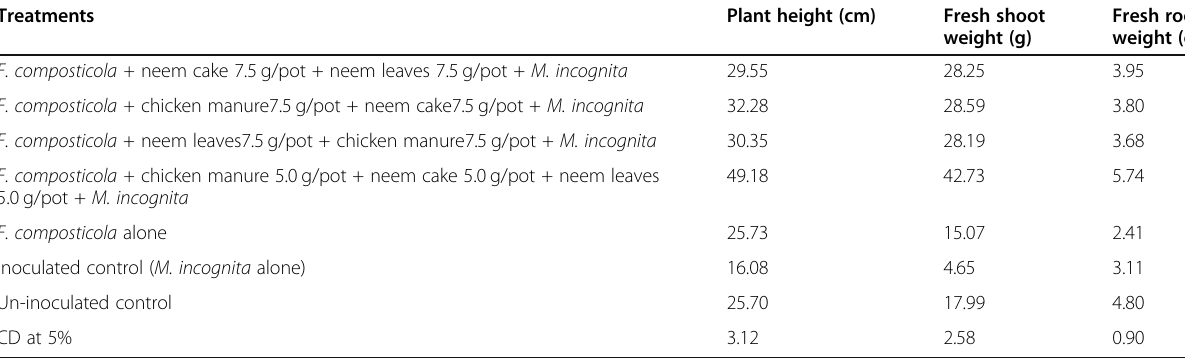
Table 1 Effect of Fictor composticola and organic amendments in different combinations on growth parameters of cucumber infected with Meloidogyne incognita Treatments